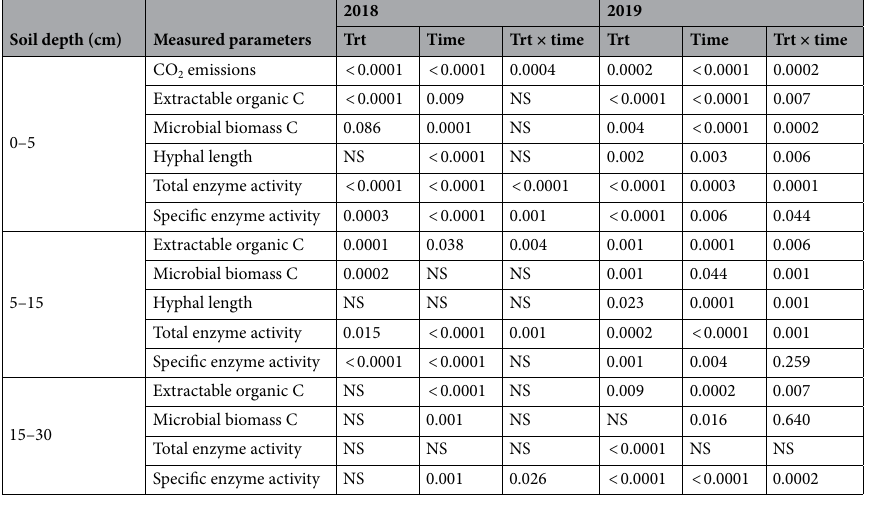
Table 1. Repeated measures ANOVA statistics (p value) for soil moisture (treatments) and sampling time effects on various measured parameters. NS means